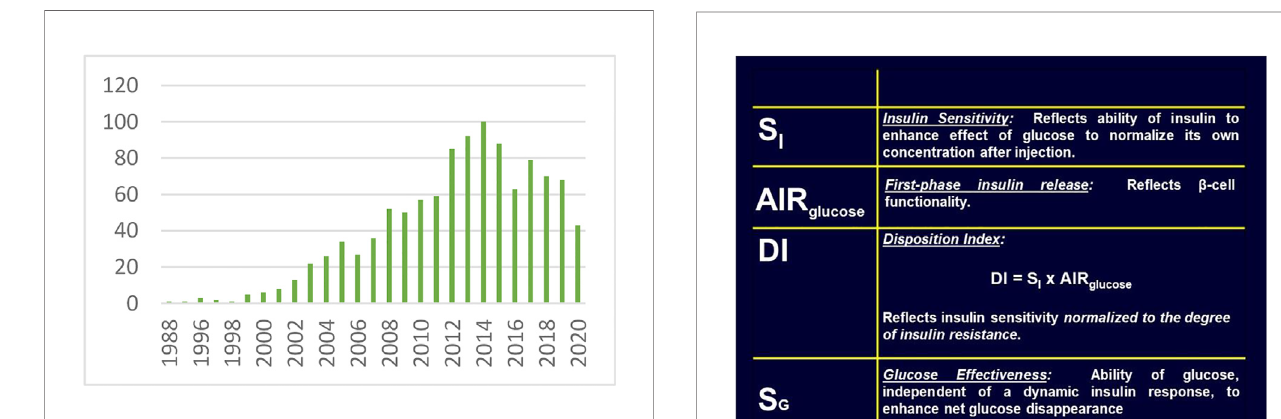
FIGURE 13 | Cited publications pertaining to the DI.